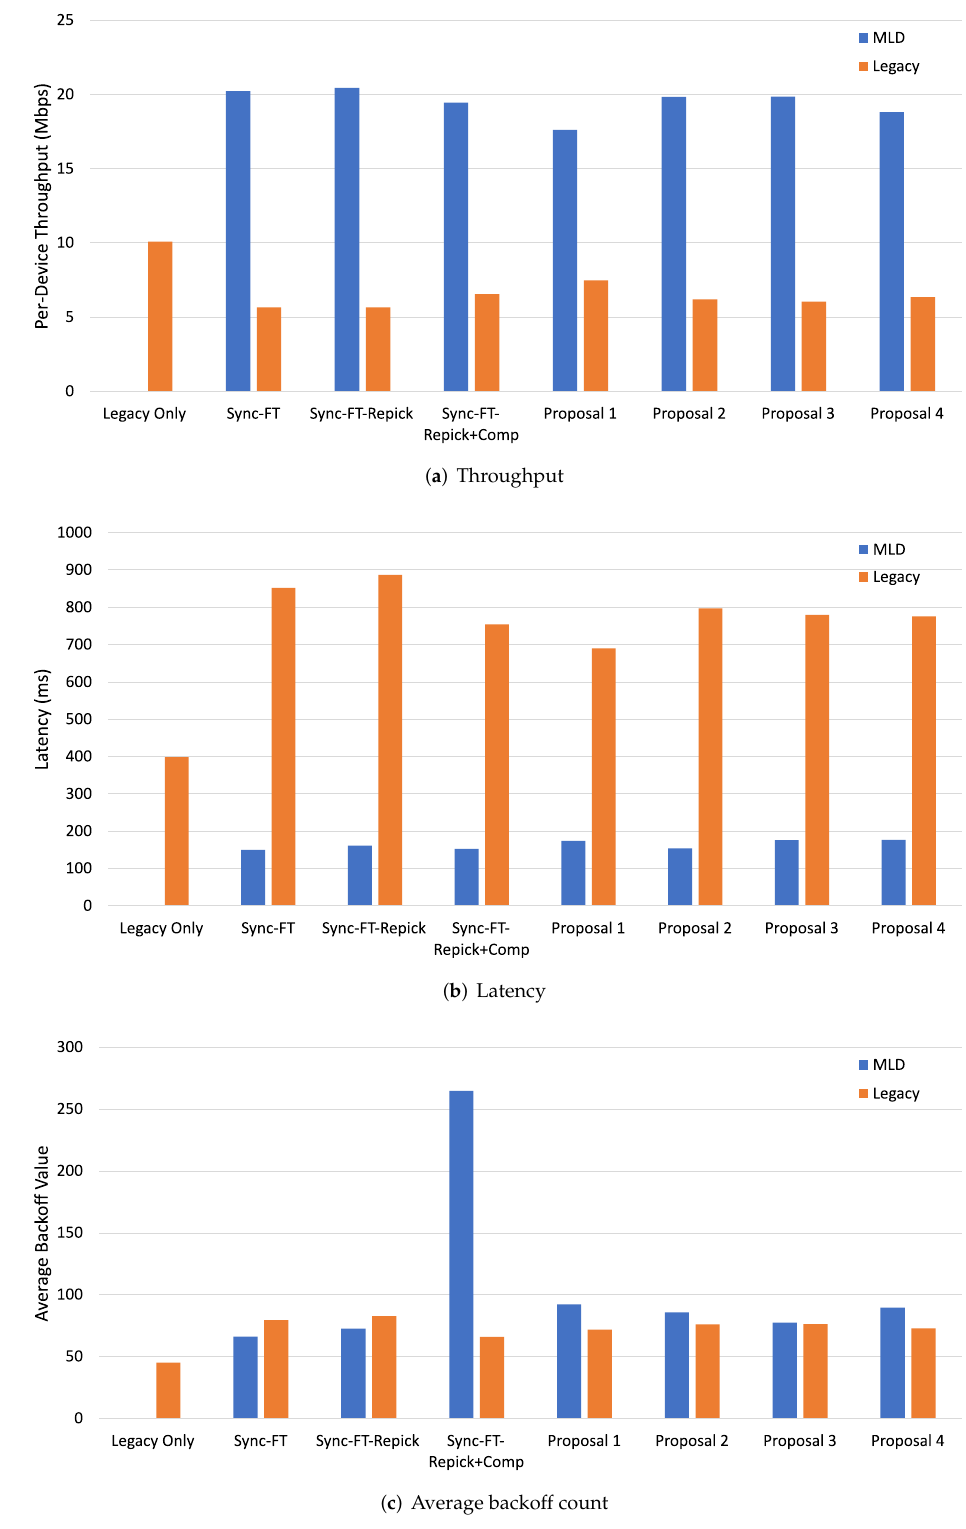
Figure 11. MLD vs. legacy SLD performance in the 3GPP indoor deployment